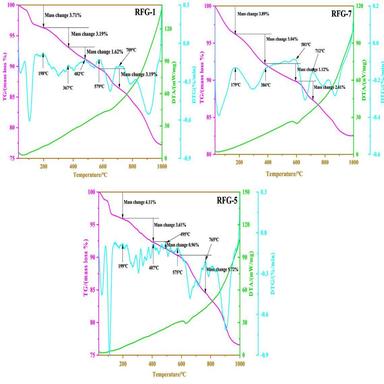
TG pattern of RFG-1, RFG-5 and RFG-7 for 7d curing.